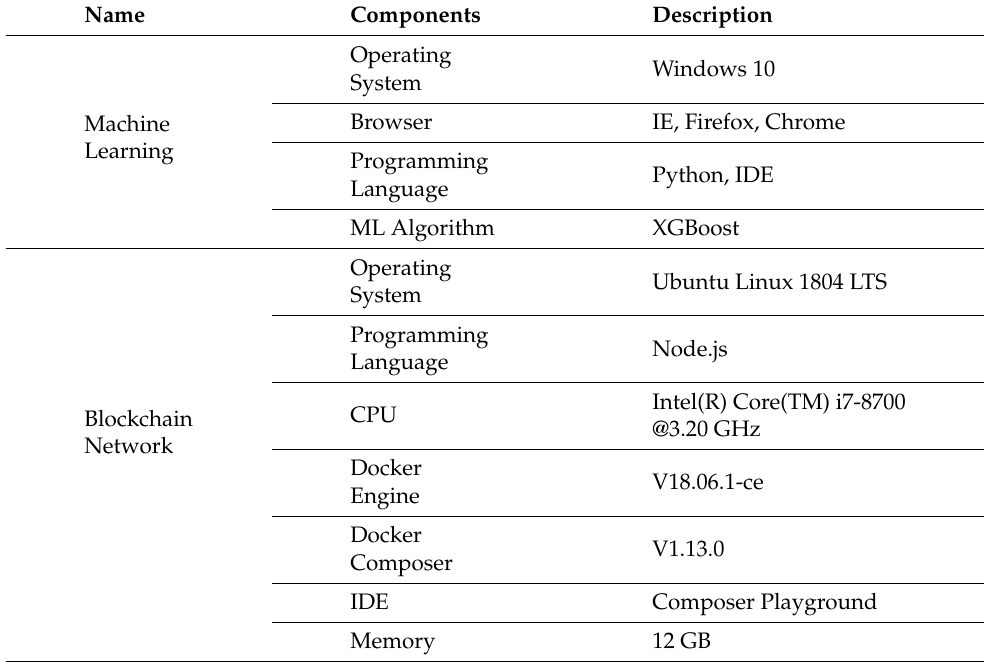
Table 2. Development